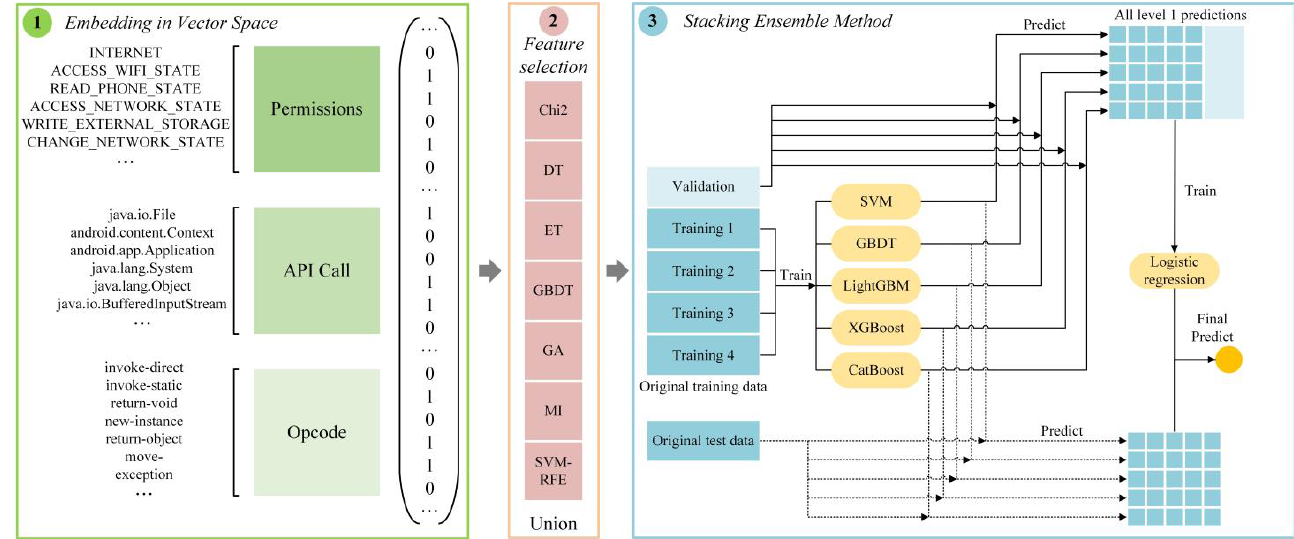
Figure 1. The architecture of MFDroid.